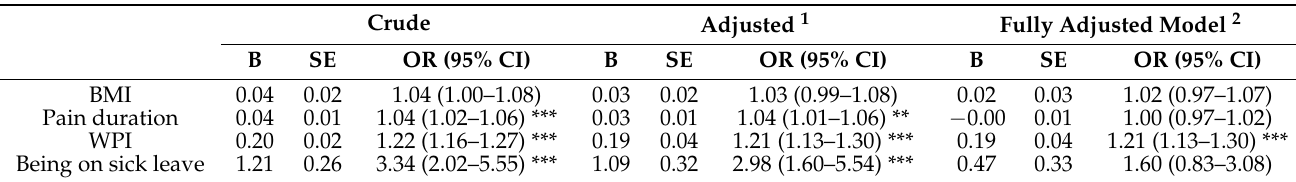
Table 5. Generalized ordinal logistic regression assessing the association between the total number of comorbid conditions (dependent variable) and WPI, pain duration, sick leave, and BMI in pain